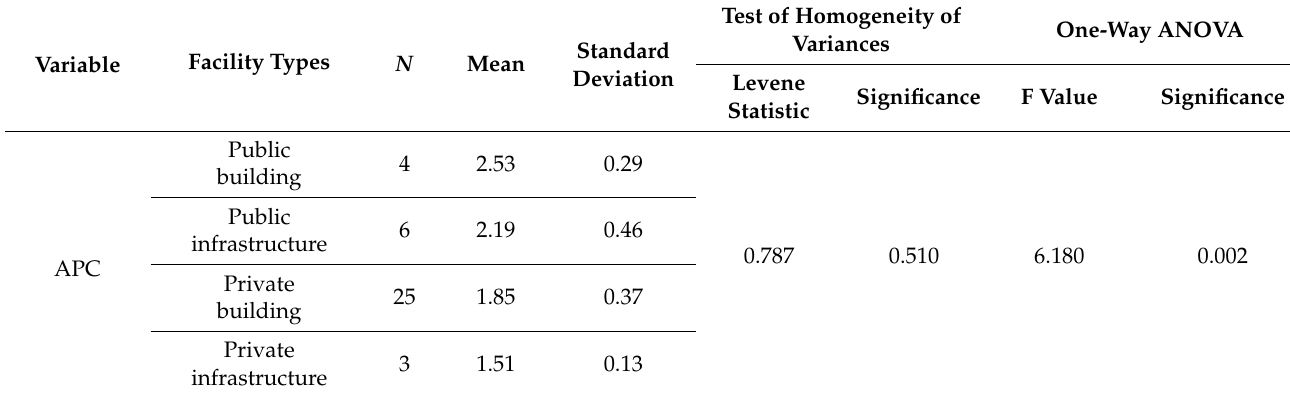
Table 13. Post hoc test outcomes.